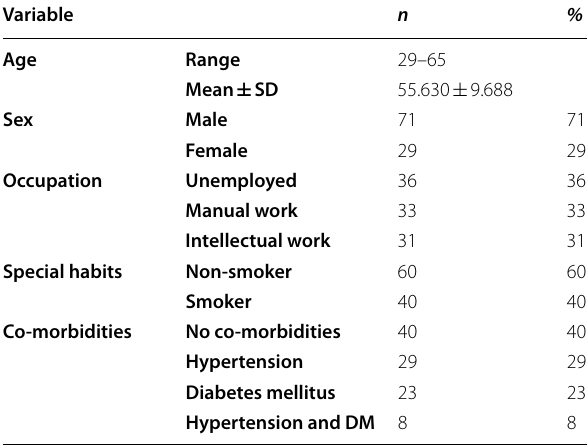
Table 1 Socio-demographic data of the studied patients Table 2 The mean values of the evaluated parameters in